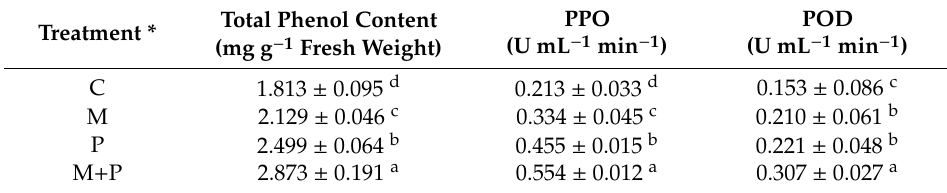
Figure 6. A photograph showing full sunflower plants (at 28 dpi) in response to colonization with R. irregularis and/or infection with R. solani ( a ), as well as the disease symptoms ( b – d ), where, C = untreated control, M = colonized with R. irregularis , P = infected with R. solani , and M+P = colonized with R. irregularis and infected with R. solani . Table 5. The mean total phenol content and activities of polyphenol oxidase (PPO) and peroxidase (POD) enzymes in sunflower roots in response to colonization with R. irregularis and / or infection with R. solani (28 days after inoculation with R. solani ).